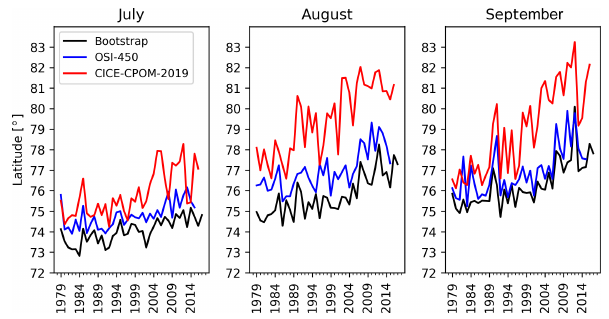
Figure 3. Time series of monthly averaged latitudes of MIZ for Bootstrap (black), OSI-450 (blue), and model CICE-CPOM-2019 (red).